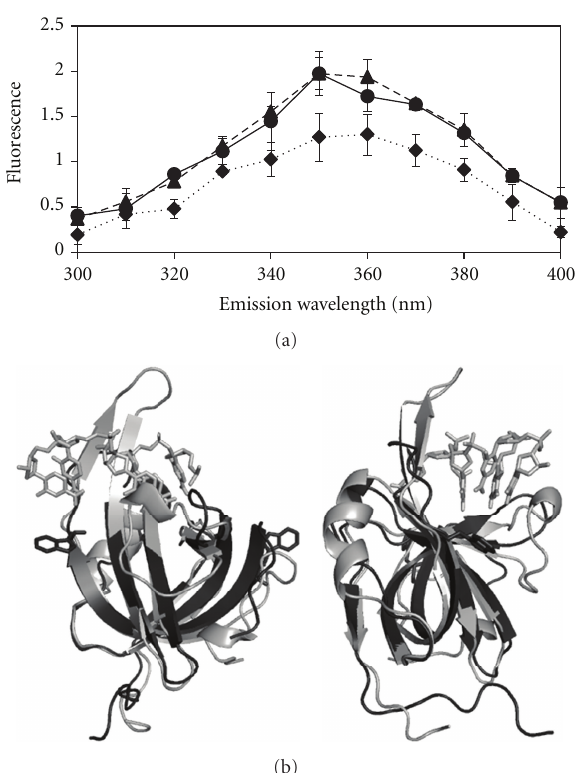
Figure 3: (a) Intrinsic fluorescence spectra for HvRPA3 incubated in 0.2 (dotted line), 1M (dashed line), and 3M (solid line) KCl. The x axis shows the wavelength of the emission spectra (nm) and the y axis the observed fluorescence. (b) Homology modelling of the HvRPA3 OB-fold (76–170). The HvRPA3 model (dark grey) and human RPA70-ssDNA (1JMC) complex (light grey) are shown in cartoon representation in two orthogonal views [27]. DNA is shown in stick form. The two tryptophan residues in HvRPA3 are shown in stick representation. 1JMC contains two OB-folds and a 8mer ssDNA, for clarity only the first OB-fold and the proximal 4 nucleotides are shown. Produced using PyMol [34].